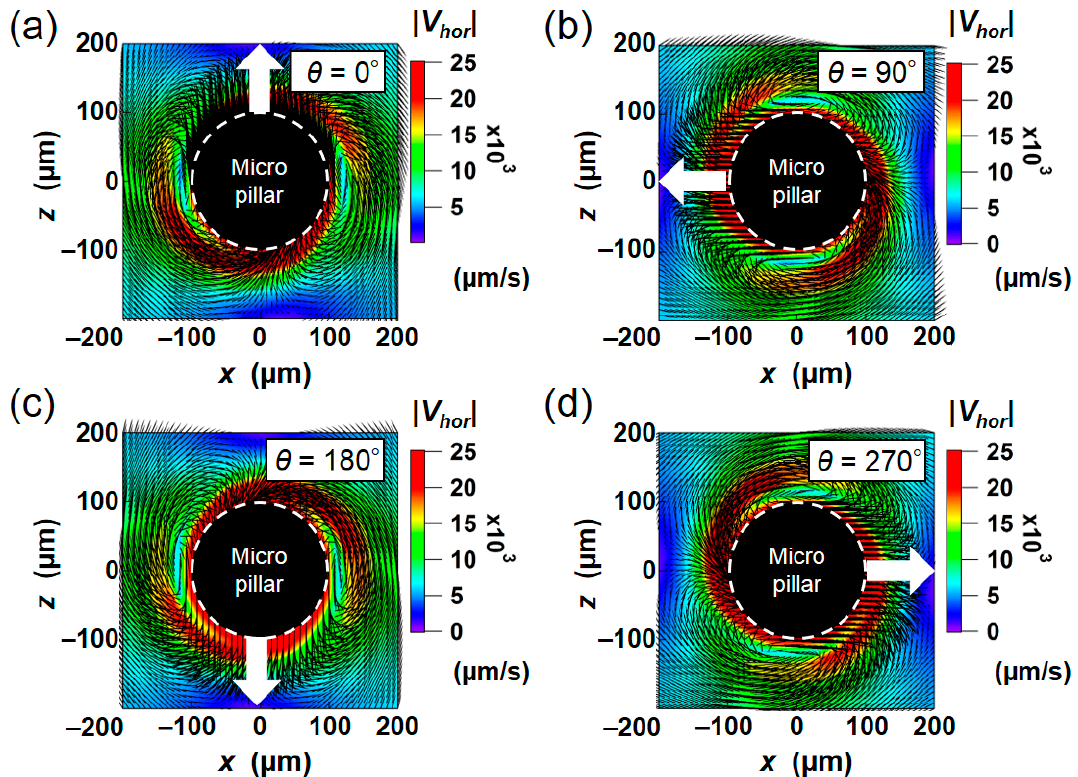
Figure 5. 2D vector plot of the instantaneous velocity field at phases of ( a ) 0°, ( b ) 90°, ( c ) 180°, ( d ) 270° within the one rotational cycle. White arrows indicate the instantaneous moving directions of the pillar.